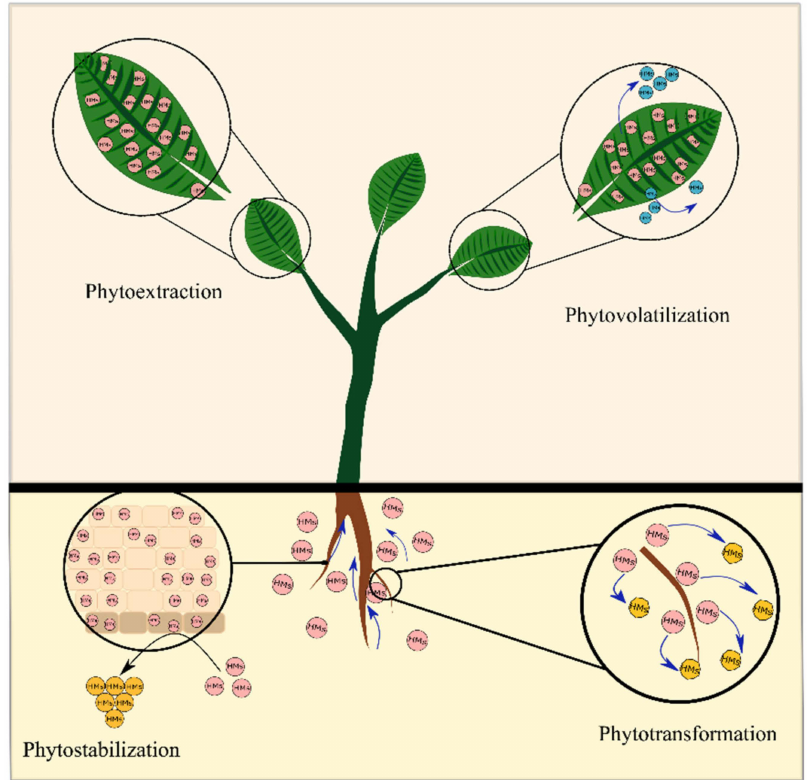
Figure 1. Main phytoremediation techniques for the remediation of contaminated environments. HM: Heavy